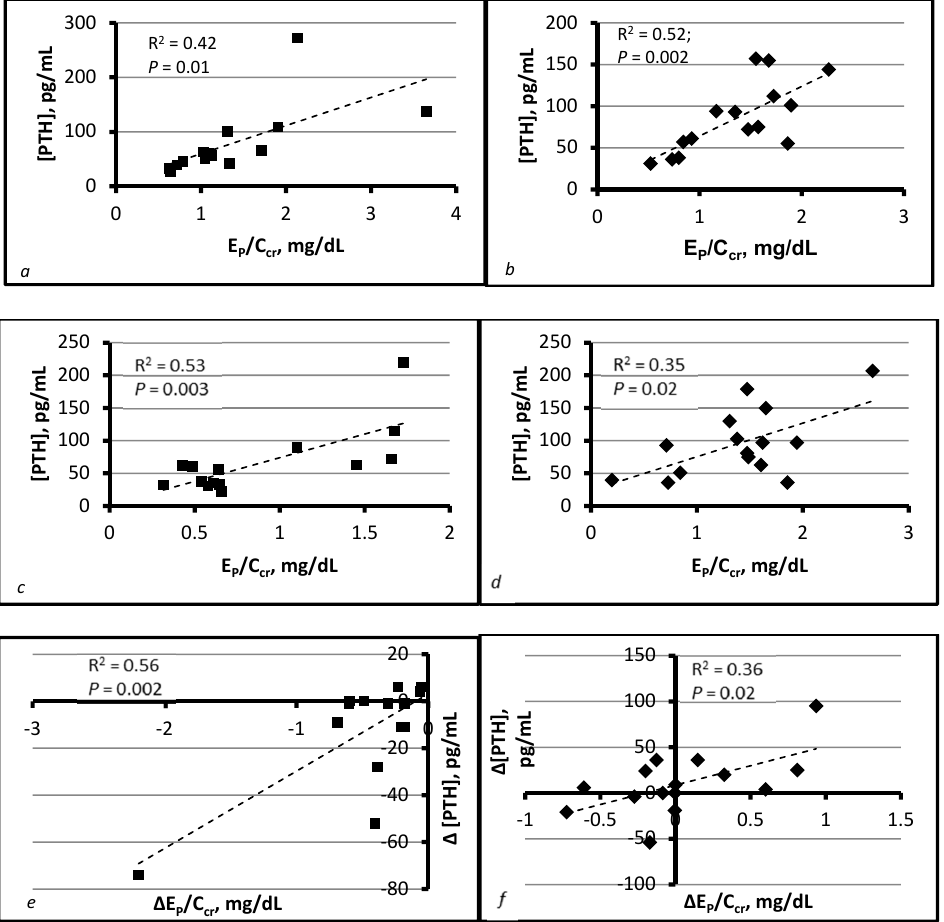
Figure 2. Relationship of [PTH] to E P /C cr in sevelamer and placebo recipients. Squares pertain to the sevelamer group and diamonds to the placebo group. Graphs ( a ) and ( c ) show regressions of [PTH] on E P /C cr before and after administration of sevelamer carbonate for four weeks. Graphs ( b ) and ( d ) show the same regressions before and after administration of a placebo for four weeks. Graphs ( e ) and ( f ) show regressions of ∆ [PTH] on ∆ E P /C cr in the sevelamer and placebo groups, respectively, where “ ∆ ” = change during treatment. All regressions are statistically significant. Adapted from [17] with permission of the publisher (Dustri-Verlag). E P , urinary excretion rate of phosphorus, mass/time; C cr , creatinine clearance, volume/time.